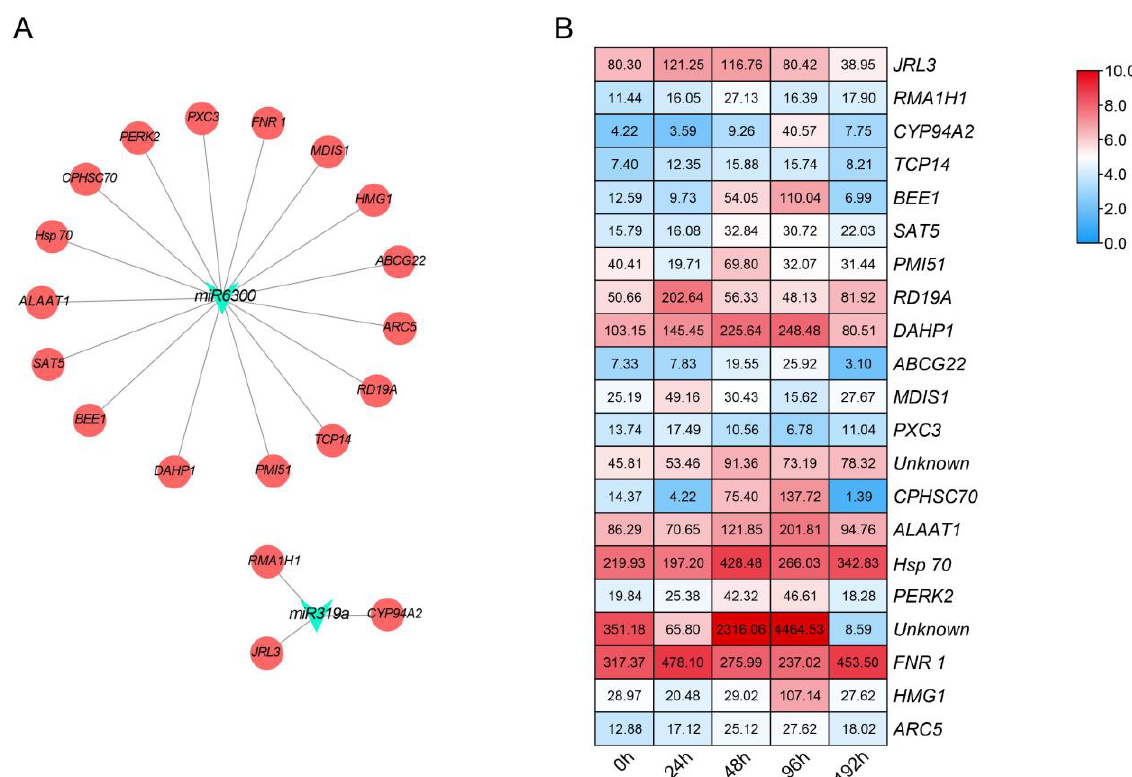
Figure 3. Functional classification of the targets of the miR319a and miR6300 . The gene classification analysis was on the basis of GO enrichment. The ordinate represents the gene functions, and ab- scissa represents the number of genes.